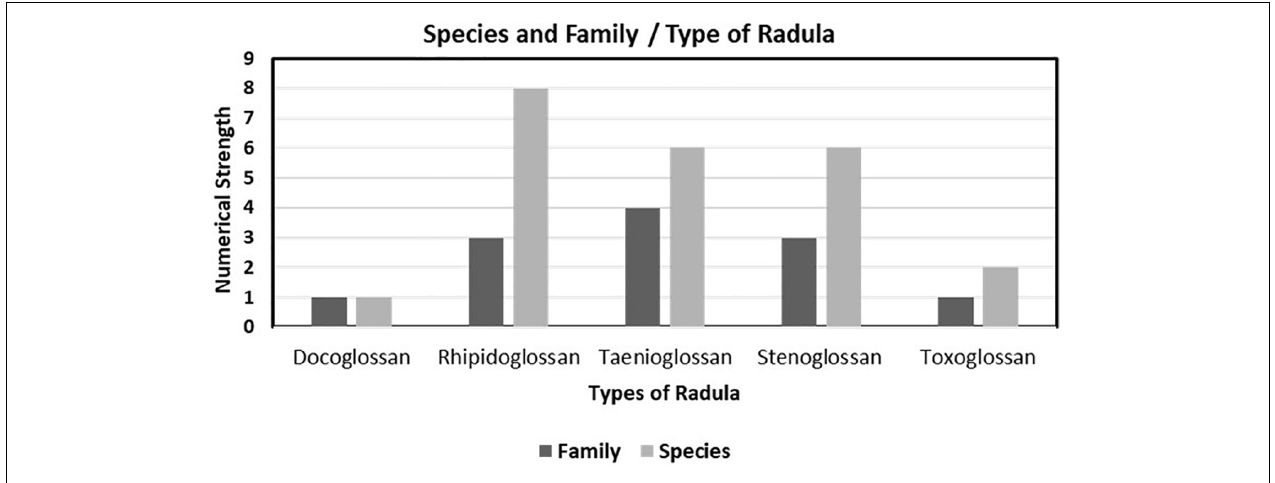
FIGURE 1 | Species and family ratio of different types of radula observed in selected coast.